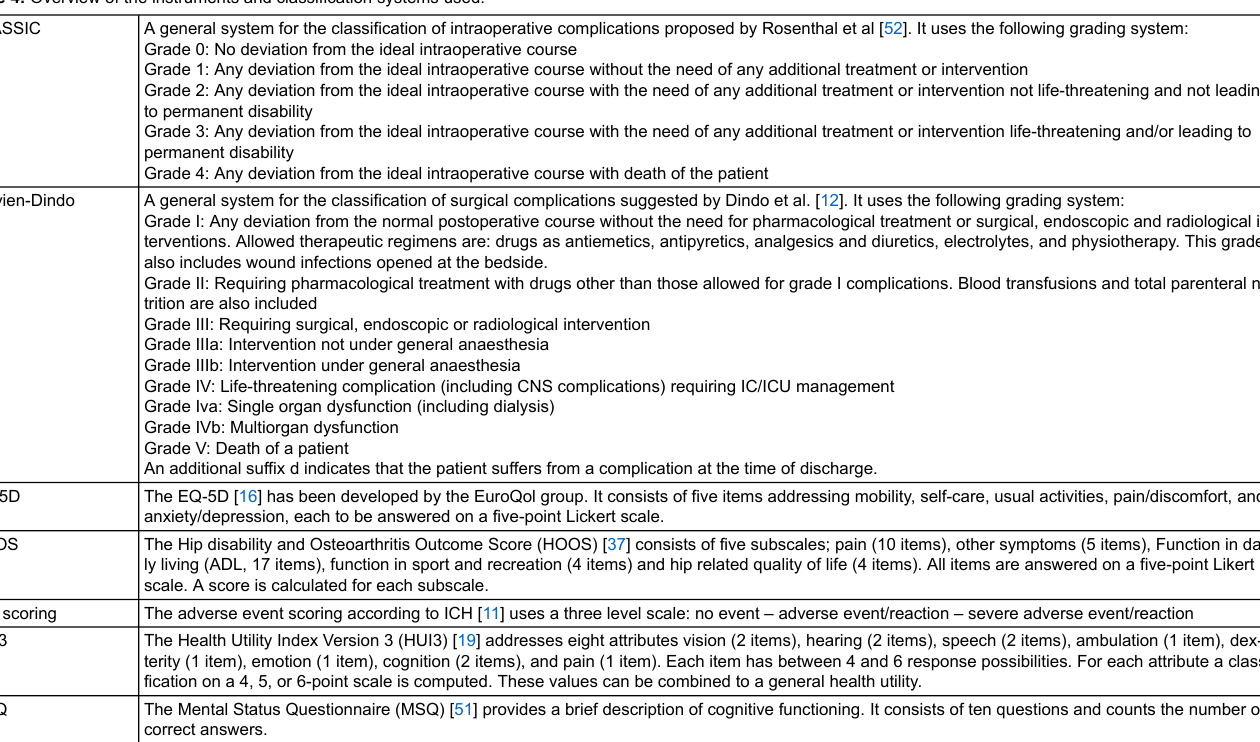
Table 4: Overview of the instruments and classification systems used.